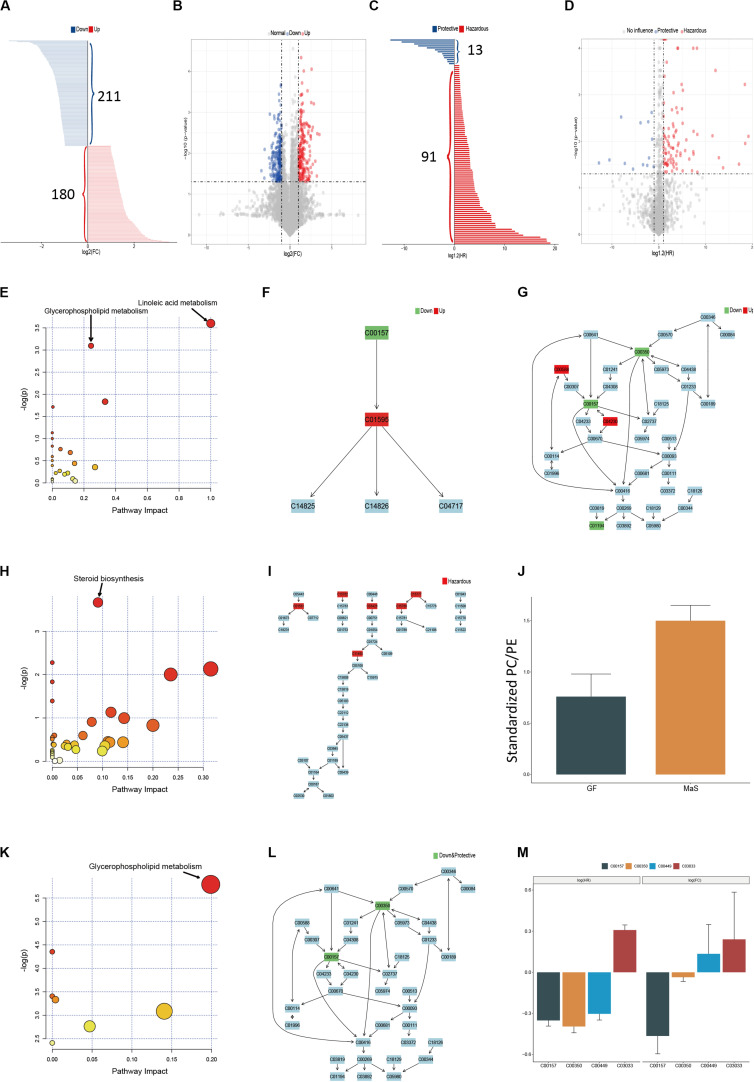
Pathway enrichment based on metabolites associated withdonor MaS, graft failure and their intersection. (A) Bar chart discriminating the components with significant increments (red bar, n = 180) or decrement (blue bar, n = 211) in MaS grafts; (B) Volcano plot on visualization of both FC and significance for each metabolites compared between MaS and non-MaS grafts, red dots represented significantly higher metabolits (FC > 2, P < 0.05) in MaS grafts, blue dots represented significantly lower metabolits (FC < 0.5, P < 0.05) in MaS grafts; (C) Bar chart discriminating the components with significant hazardous (blue bar, n = 13) or protective (red bar, n = 91) effects on graft failure; (D) Volcano plot on visualization of both HR and significance for each metabolites compared between organs with and without graft failure, blue dots represented metabolites with protective effects on graft failure (HR < 0.5, P < 0.05), red dots represented metabolites with harzardous effects on graft failure; (E) Results for pathway enrichment based on metabolits with difference between MaS and non-MaS grafts, pathway on linoleic acid and glycerophospholipid metabolism were significantly associated with donor MaS (P < 0.05); (F) Details of linoleic acid metabolism pathway and related metabolites involved in donor MaS; (G) Details of glycerophospholipid metabolism pathway and related metabolites involved in donor MaS; (H) Results for pathway enrichment based on differential metabolites in univariate cox proportional analysis on graft failure, pathway on steroid biosynthesis was significantly associated with graft failure; (I) Details of steroid biosynthesis and related metabolites involved in graft failure; (J) Standardized PC/PE ratios in subgroup patients received MaS grafts or cases with graft failure occurrence; (K) Results for pathway enrichment based on metabolites intersective between E and H, pathway on glycerophospholipid metabolism was significantly associated with MaS related graft failure; (L) Details of glycerophospholipid metabolism pathway and related metabolites involved in MaS-related graft failure; (M) Metabolites both involved in MaS and graft failure. Green box presented down-regulation in MaS grafts and/or protective effect on graft failure; Red box represented up-regulation in MaS and/or hazardous effects on graft failure. FC, fold change; HR, hazard ratio; MaS, macrosteatosis; PC, phosphatidylcholine; PE, phosphatidylethanolamine.